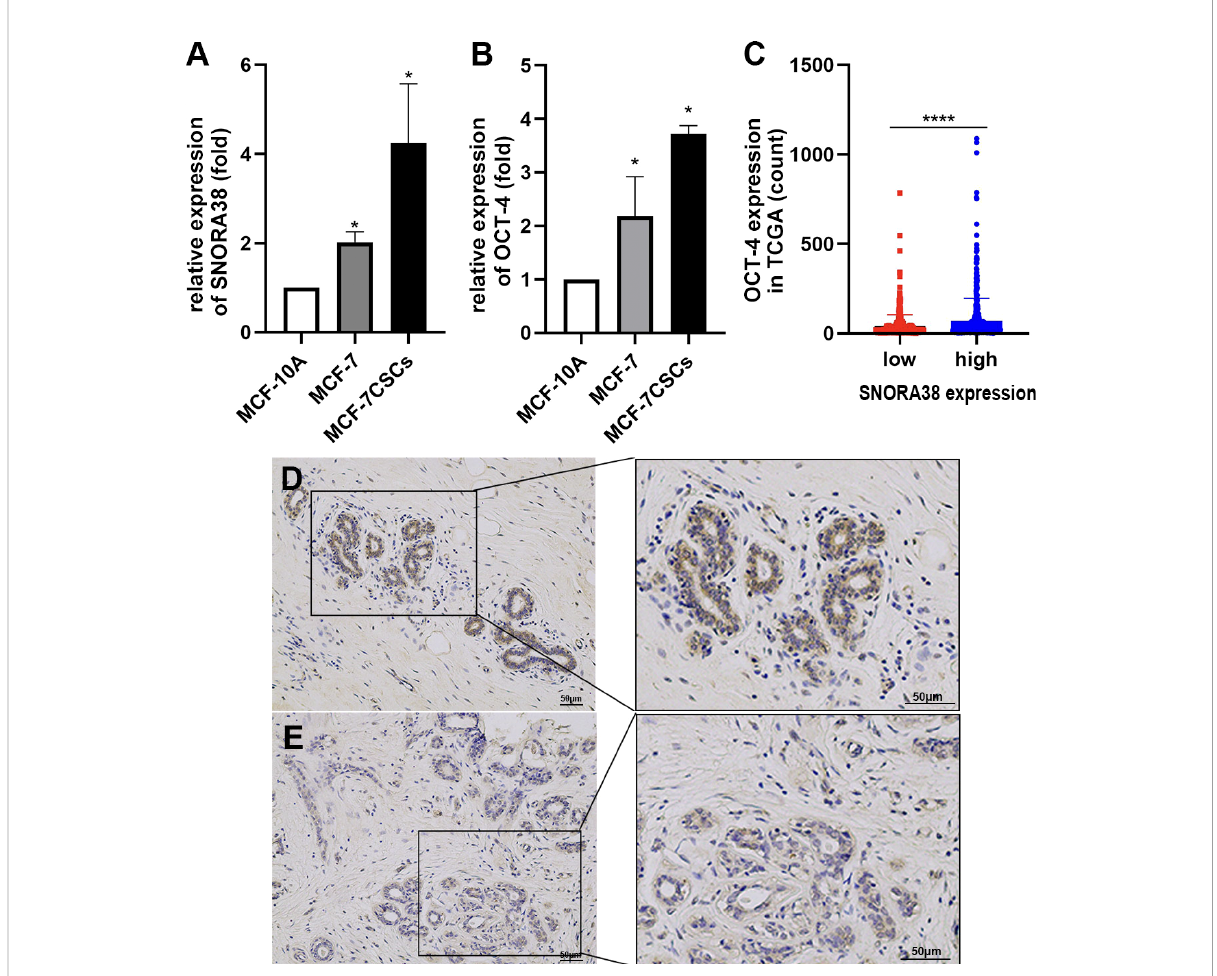
FIGURE 4 SNORA38 expressed higher in the BCSCs than BCCs and was related to breast cancer stemness. (A) relative expression of SNORA38 in MCF- 10A,MCF-7, and MCF-7CSCs (B) relative expression of OCT-4 in MCF-10A, MCF-7, and MCF-7CSCs (C) OCT-4 expressed higher in high SNORA38 expression group than in low SNORA38 expression group in breast cancer in TCGA (D) high expression of OCT-4 in IHC (E) low expression of OCT-4 in IHC * P < 0.05 and **** P <